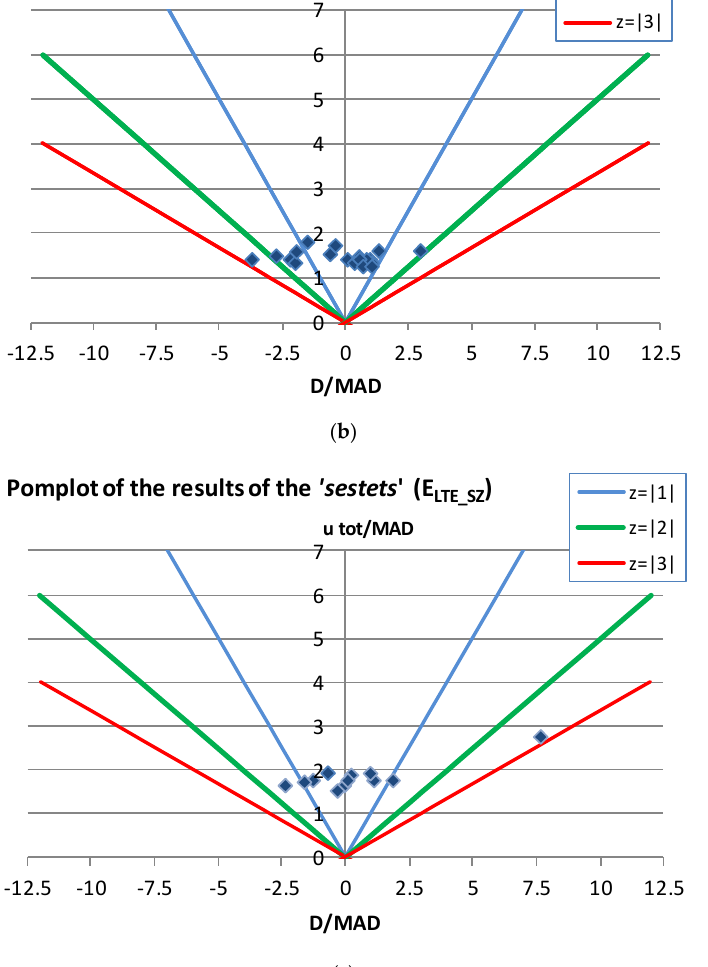
Figure 7. PompPlots of the results of the ‘sestets’ in the three modalities: ( a ) E CP . ( b ) E LTE_RS . ( c ) E LTE_SZ .